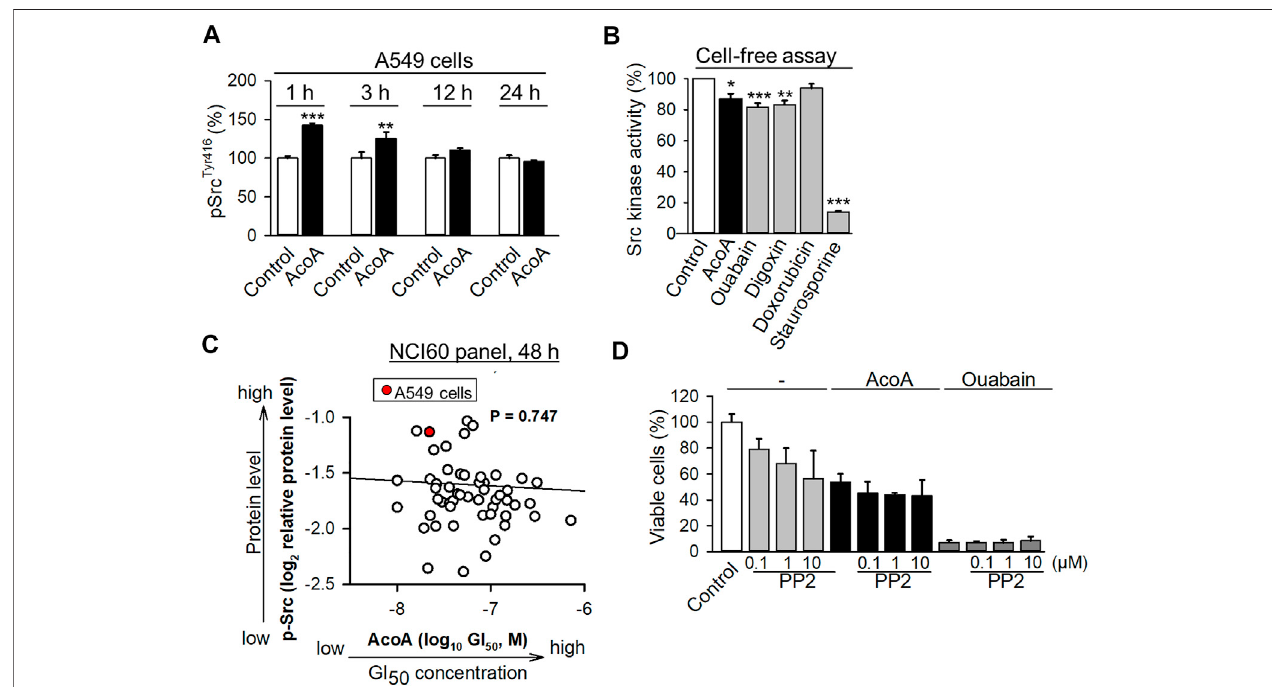
FIGURE4| AcoAactivatesSrckinaseinA549cells,butreducestheactivityofrecombinantSrckinaseinacell-freeassay. (A) A549cellsweretreatedwithAcoAfor 1to24 h, lysed and thecelllysateswereanalyzed foractivationoftheTyr416 phosphorylationsite ofSrckinase usingacommercial ELISAassay.Dataare mean ± SEM of N (cid:1) 3,** p < 0.01,*** p < 0.001incomparisontocellsincubatedwithvehiclefortheindicatedtime. (B) AcoA,ouabainanddigoxinreduceSrckinaseactivityinacell-free assay. Enzymatic activity of recombinant c-Src kinase (0.1 U/mL) pretreated with AcoA, ouabain, digoxin, doxorubicin, or the positive control staurosporine (all 100 nM) for 30 min, was analyzed by a kinase assay. Data are mean ± SD of triplicates, * p < 0.05, ** p < 0.01, *** p < 0.001 in comparison to the vehicle control. (C) Src activation ( p -Src Y416 expression) in the NCI-60 tumor cell lines does not correlate with AcoA cytotoxicity (GI 50 values) in the same cell lines (original data were obtained from NCI database). Red dot indicates A549 cell line. Pearson correlation test. (D) AcoA and ouabain-induced cell toxicity is unaffected by the Src inhibitor PP2. Cell viabilityofA549cells pretreated for 4 h with theSrc kinase family inhibitor PP2and incubated for 48 h with AcoA or ouabain (100 nM). XTT assay, mean ± SEMof N (cid:1)